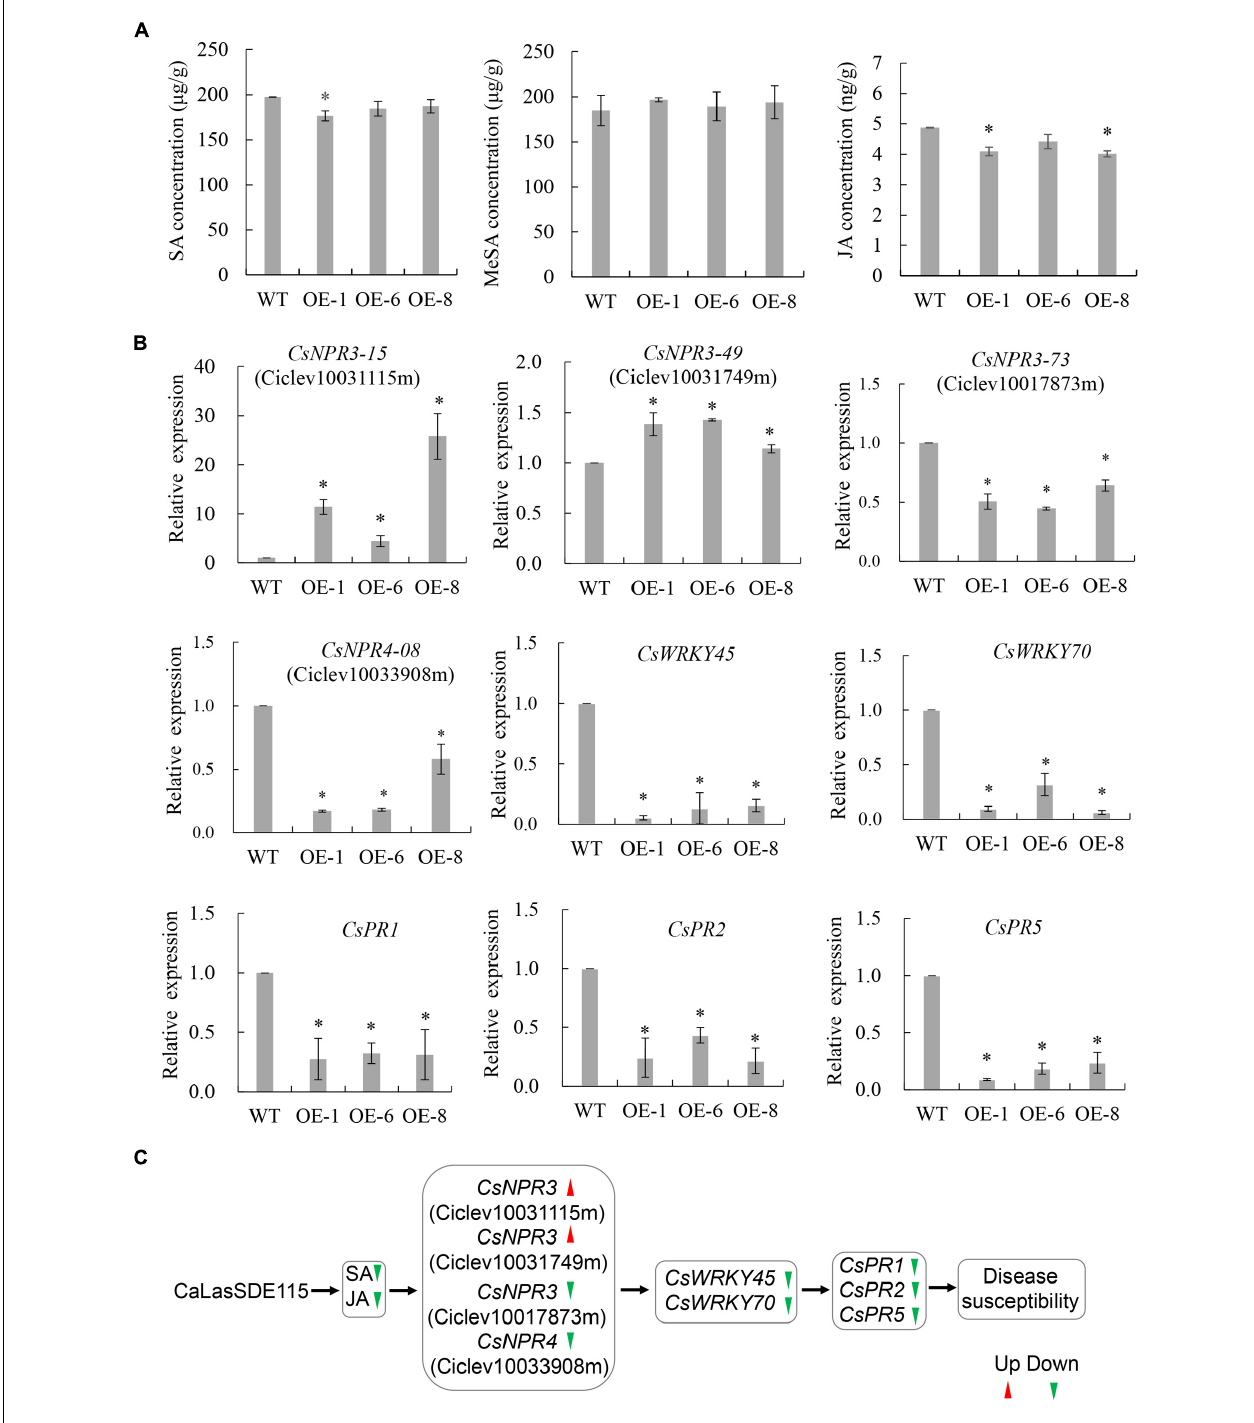
FIGURE 7 | SAR characteristics of transgenic plants overexpressing mSDE115 . (A) Characteristics of SA, MeSA, and JA contents in transgenic plants compared to WT control. (B) Expression characteristics of SAR-associated genes in transgenic plants. Compared to WT control, relative expressions were determined using GAPDH gene (Mafra et al., 2012) as internal reference. (C) Illustration of the transcriptional regulation of SAR response modulated by Ca LasSDE115 effector in citrus. Red and green arrowheads indicate up-regulated and down-regulated, respectively. Values are expressed as means ± standard deviation of three independent tests. ∗ on top of the bars indicates a significant difference ( p < 0.05, T -test). WT, wild type; OE-#, transgenic plants.